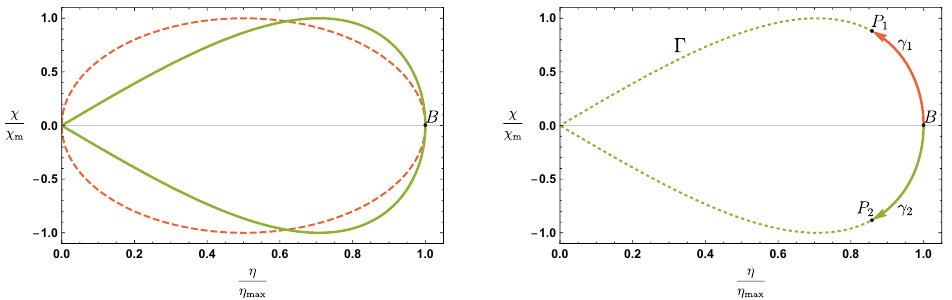
Figure 1. Trajectories Γ in the ( η , χ ) plane for a (symmetric) bouncing universe. The upper half-plane corresponds to the expanding phase, whereas the lower half-plane describes the contracting phase. The bounce is represented by the point B , where the expansion rate vanishes, and the scale factor attains its minimum (correspondingly η is maximized). The left figure shows the trajectory Γ for a universe filled with a scalar field (thick green line), or dust (dashed orange line); parameters are chosen so that the two trajectories are characterized by the same critical density ρ c and limiting expansion rate χ m . The right figure shows the two integration contours γ 1 , γ 2 used in Equation